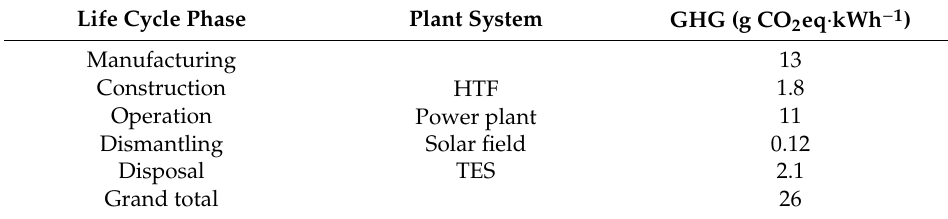
Table 6. Life Cycle (LC) Impact Metrics by System and Phase for CSP